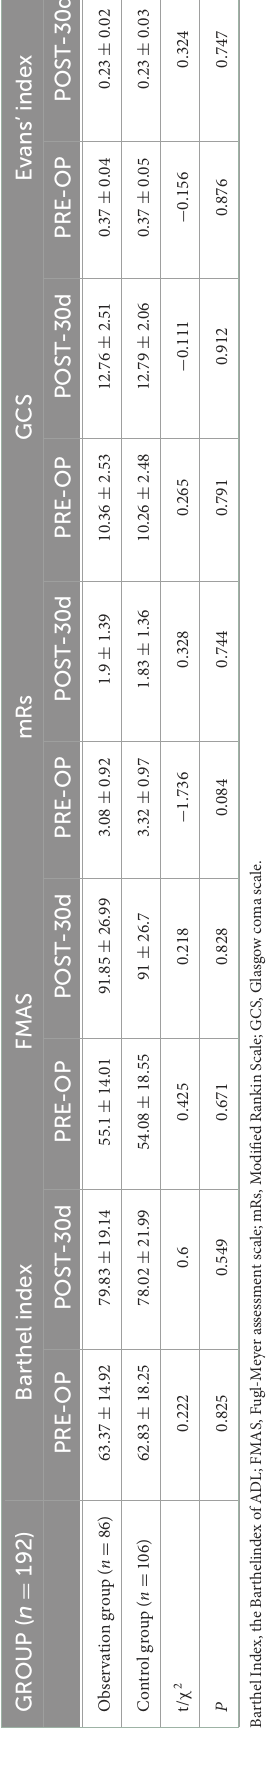
TABLE 3 Comparison of complications between the observation and control